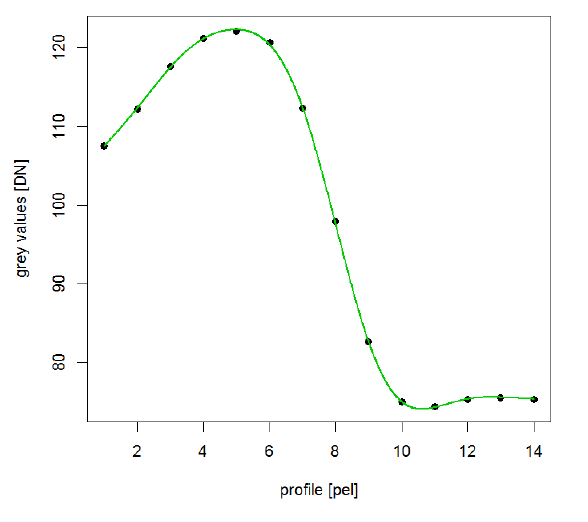
Figure 2. Course of intensity (grey) values in a profile across an edge of high contrast